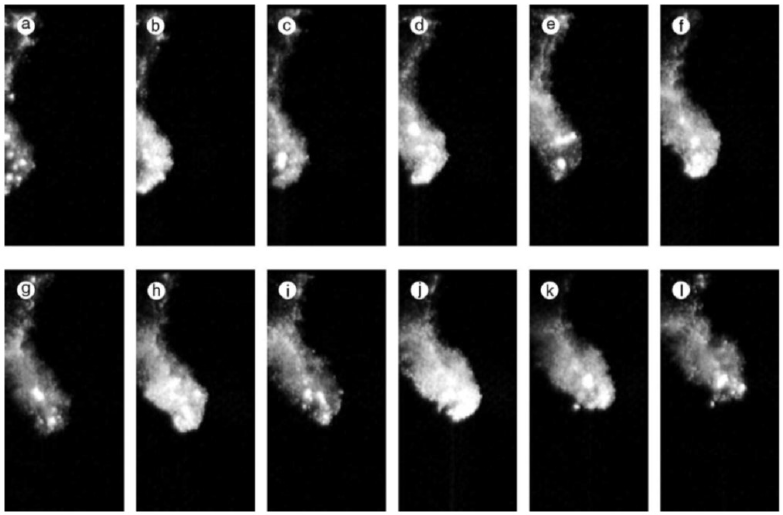
Figure 29. A bubble cluster observed at 23 kHz for the FG output of 1500 mV p-p which is almost above the threshold for the MBSL quenching [68]. Copyright 2002, with the permission from Elsevier.